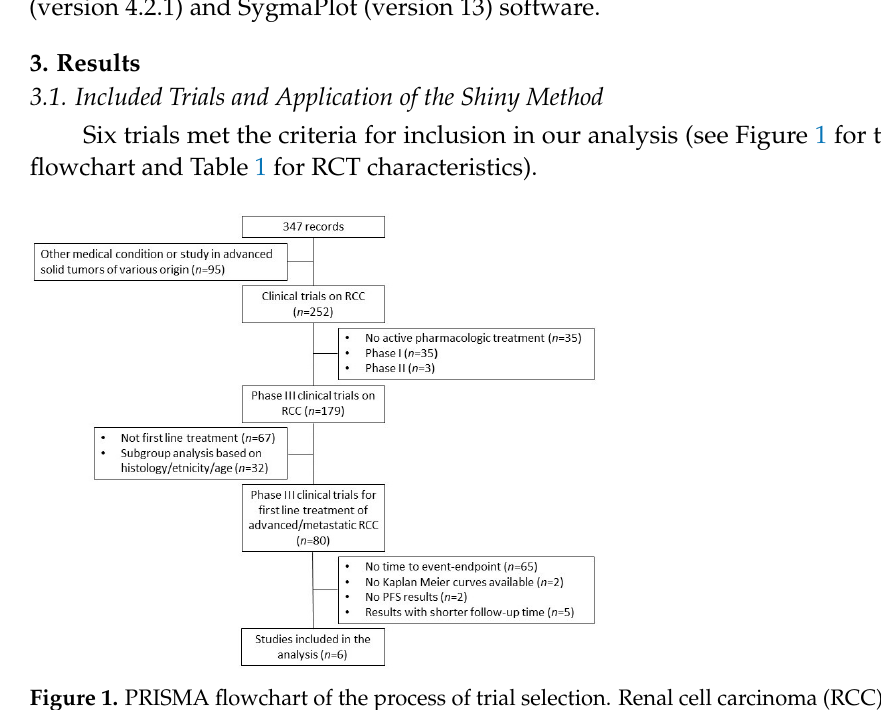
Figure 1. PRISMA flowchart of the process of trial selection. Renal cell carcinoma (RCC); Progression- Figure 1. PRISMA fl owchart of the process of trial selection. Renal cell carcinoma (RCC); Progres- free survival sion-free survival (PFS).